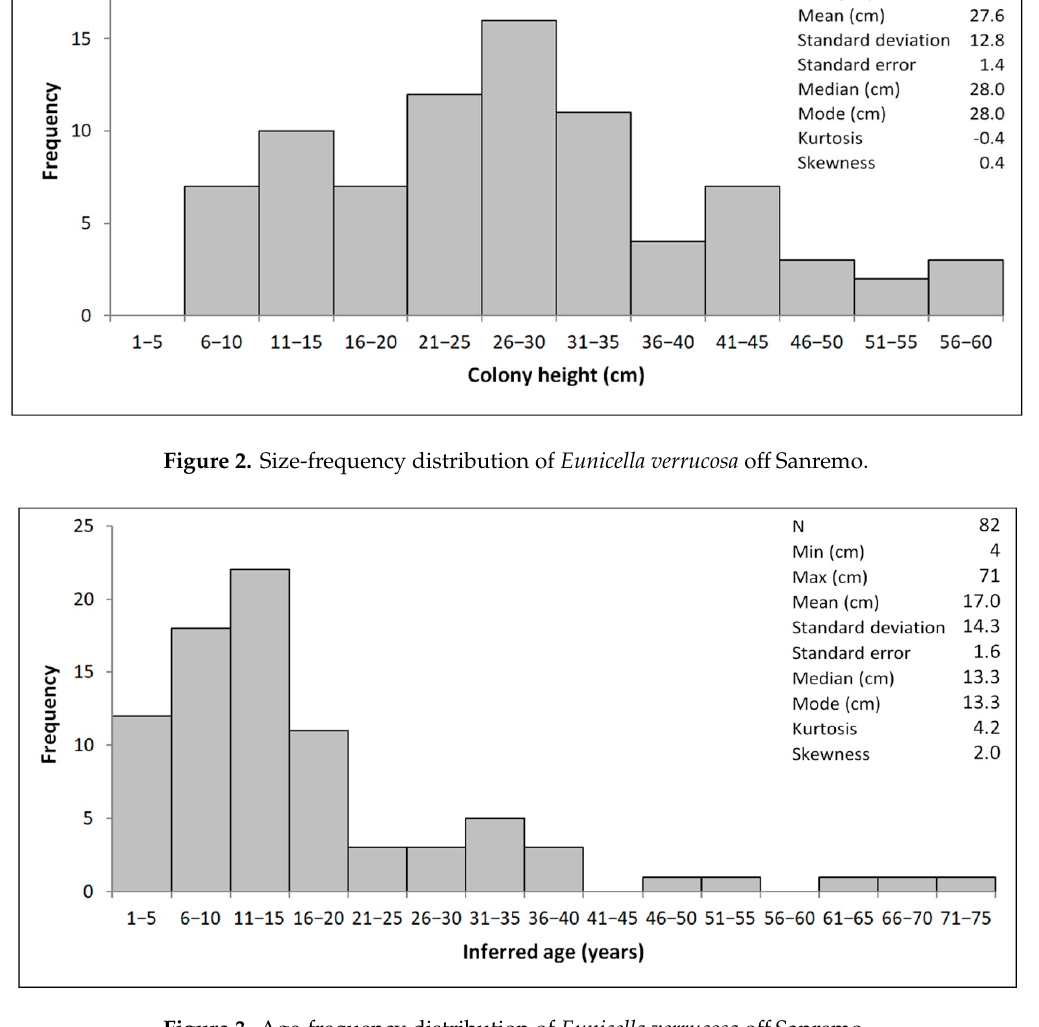
Figure 3. Age-frequency distribution of Eunicella verrucosa off Sanremo.